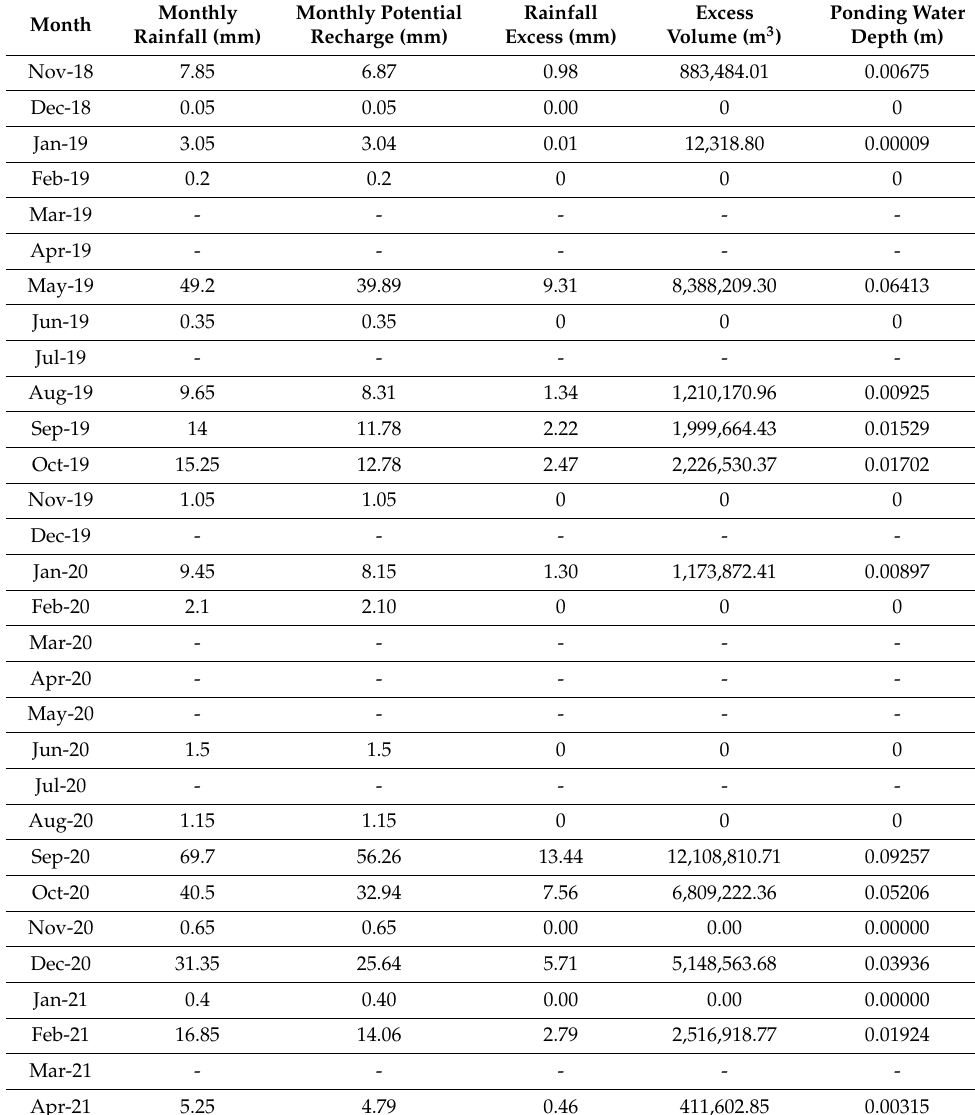
Table 9. Estimested ponding water depth on the stream